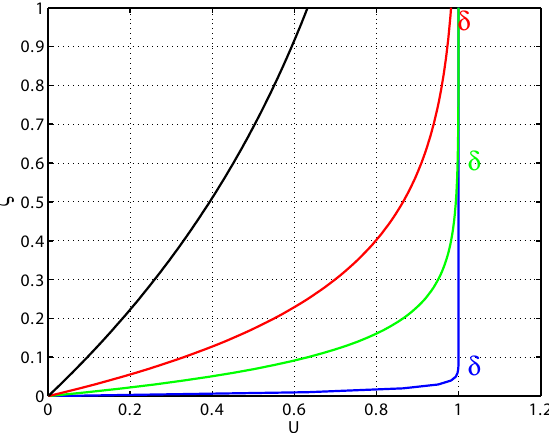
Fig. 1. Schematic showing the amplitude velocity profile for an os- cillatory current with different Stokes number; blue, green red and black have Stokes numbers of 0.01, 0.1, 0.25 and 1, respectively. The elevation has been normalised by the total water depth and the velocity by the free stream velocity. The position of the height of frictional influence is depicted by δ .